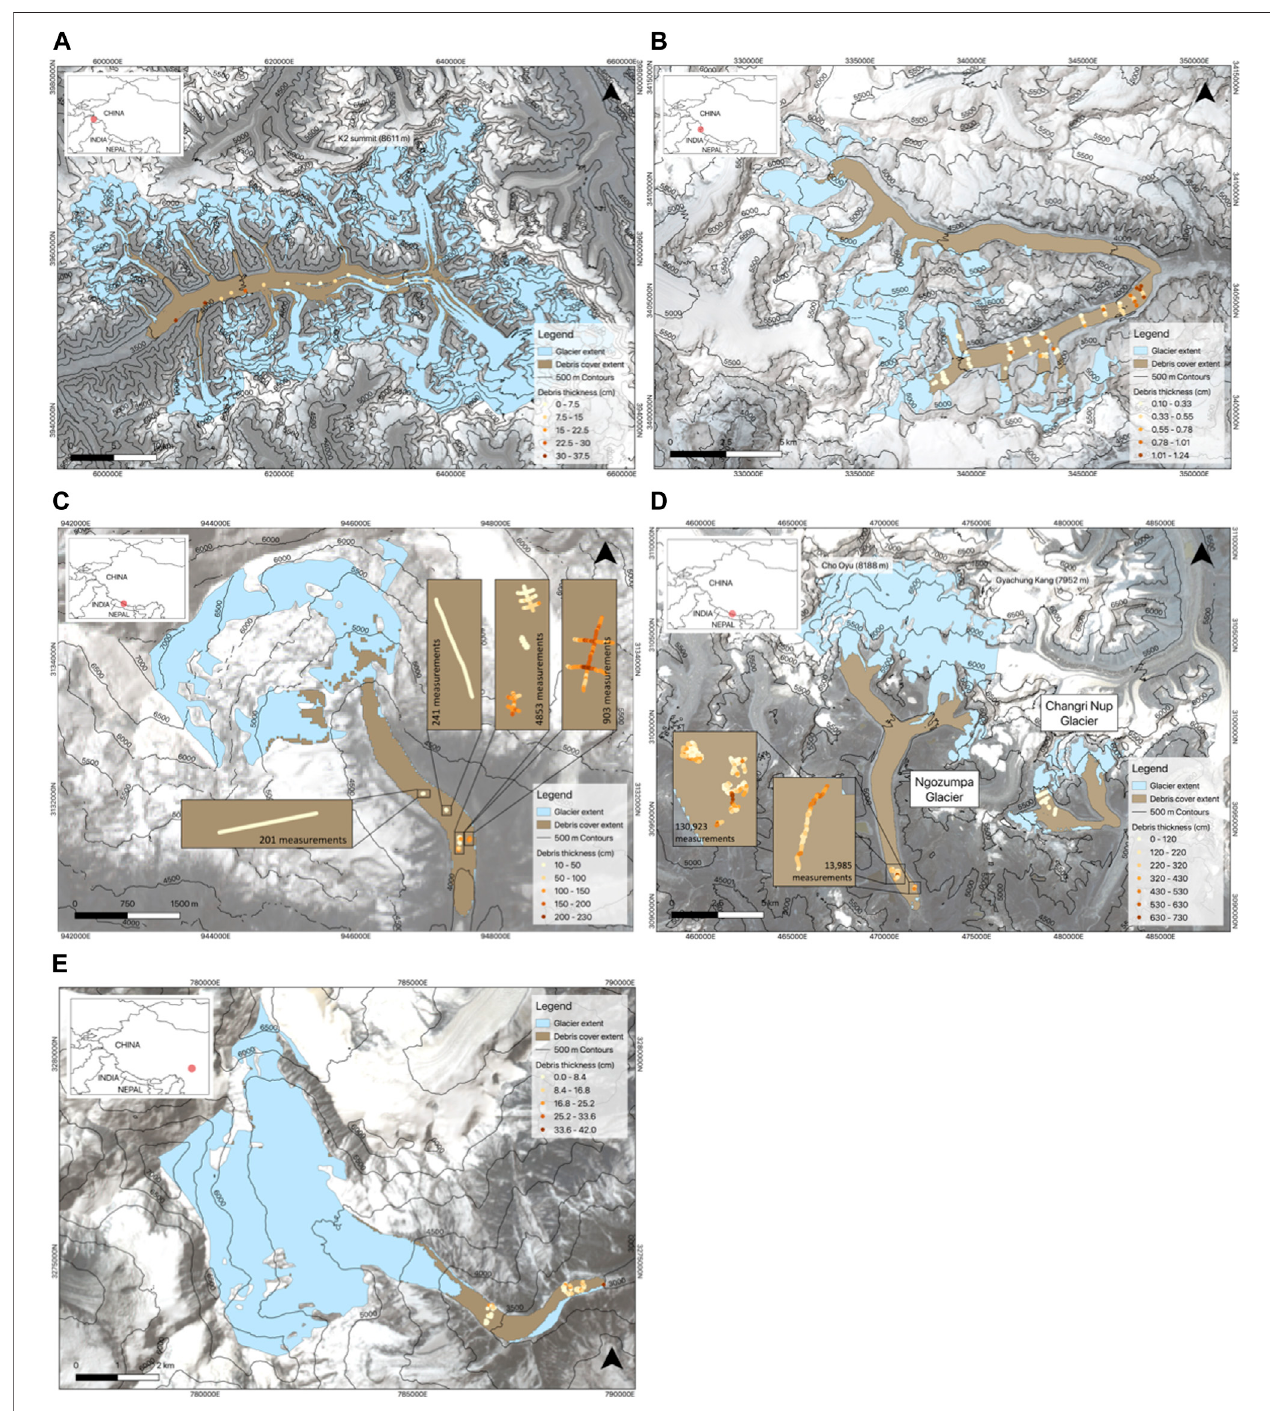
FIGURE2| Mapstoshowthedistributionof insitu debristhicknessmeasurementsfor (A) Baltoro(UTM43N), (B) Satopanth(UTM44N), (C) Lirung(UTM45N), (D) Ngozumpa and Changri Nup (UTM 45N), and (E) Hailuogou Glaciers (UTM 47N). Glacier outlines are provided by GAMDAM (Sakai, 2019) and debris cover outlines are provided by Scherler et al. (2018). Note: Giese (2019), consistent with Miles et al. (2018) and Giese et al. (2020), de fi nes the extent ofChangri Nup within the southern of the two lobes indicated in this fi gure and considers the northern lobe to be a separate glacier named Changri Shar. However, for the purposes of this study the outline provided by GAMDAM (Sakai, 2019) is used, which includes both the northern and southern lobe.